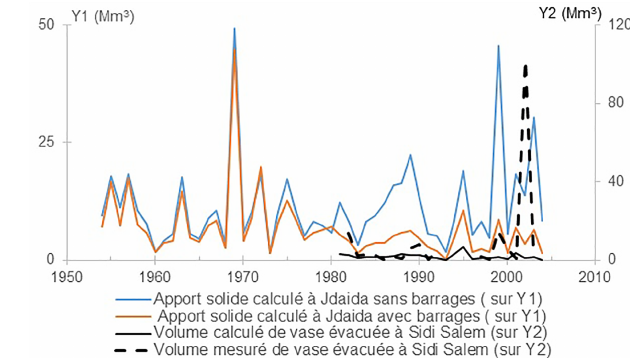
Figure 3. Evolution des apports solides calculés à Jdaida et des volumes calculés et mesurés de vase évacuée à Sidi